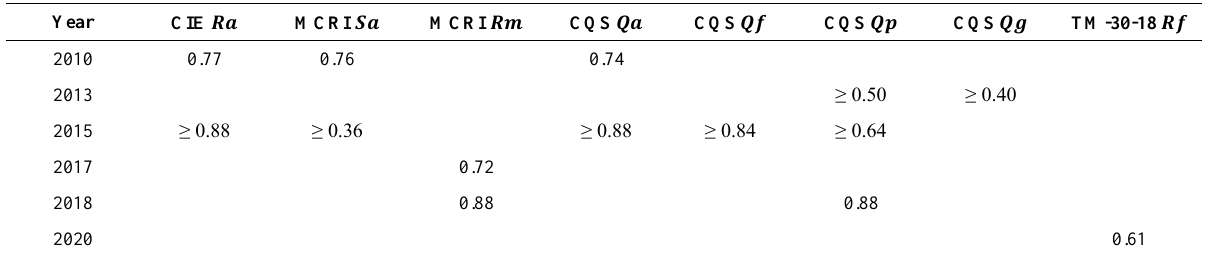
Table 3. Summary of potential Colour Naturalness metrics with quoted (or deduced) values for r 2